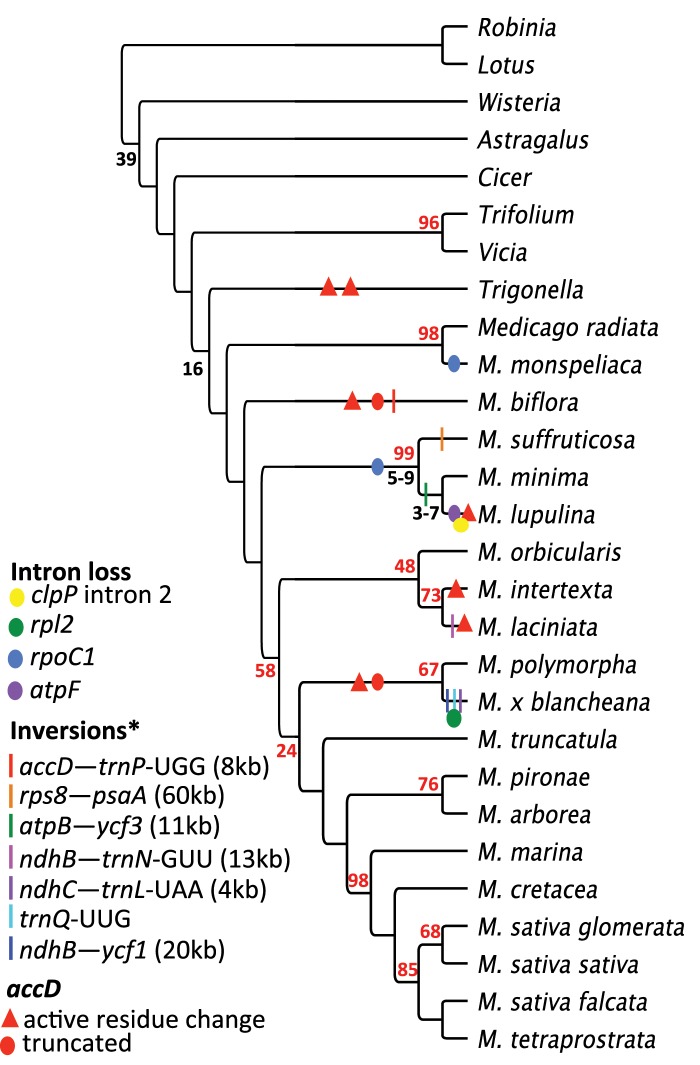
—Phylogenetic relationships and distribution of plastome structural variation. Shared coding sequences (69; see supplementary table S2, Supplementary Material online) were extracted from newly sequenced Medicago and Trigonella plastomes and combined with M. truncatula and seven additional legume taxa for construction of a phylogenetic tree. Structural features are plotted on the branches of the cladogram and indicated in the key (inset) and inversions are relative to Wisteria floribunda (asterisk). At the nodes, black numerals indicate divergence estimates in millions of years (Medicago, de Sousa et al. 2016; IRLC, Lavin et al. 2005) and bootstrap values <100 are indicated by red numerals. Active site residue changes in the Acetyl-coenzyme A carboxylase carboxyl transferase subunit beta polypeptide are diagrammed in supplementary figure S1, Supplementary Material online.